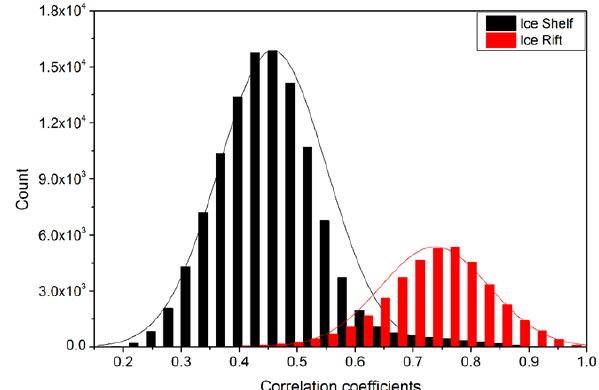
Figure 3. Histogram of correlation coefficients of matched points for the ZY-3 DEM: points inside Rift T2 (red) and points on the ice shelf